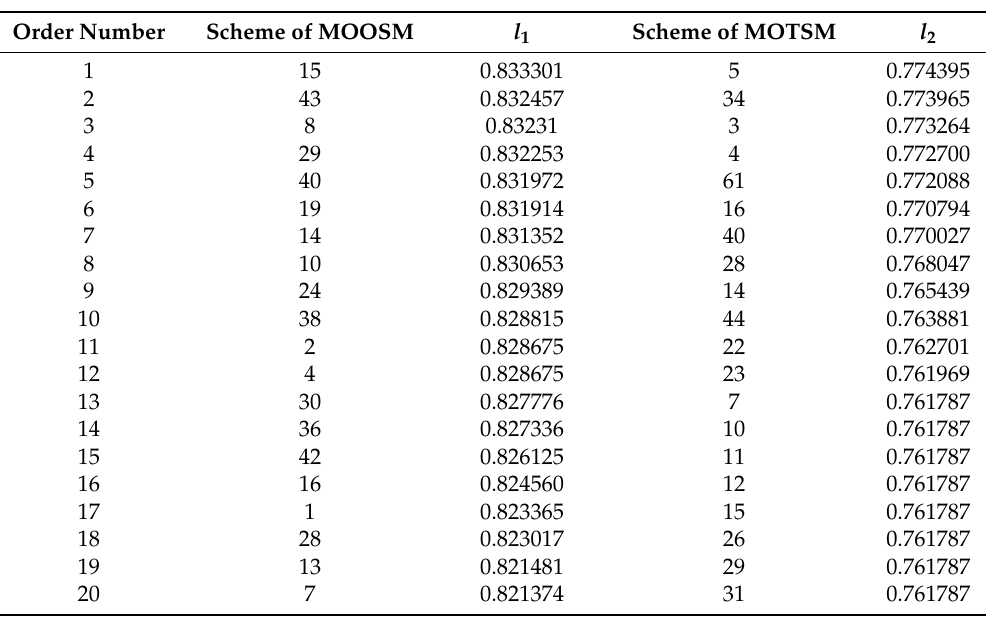
Table 4. The sorting results of two